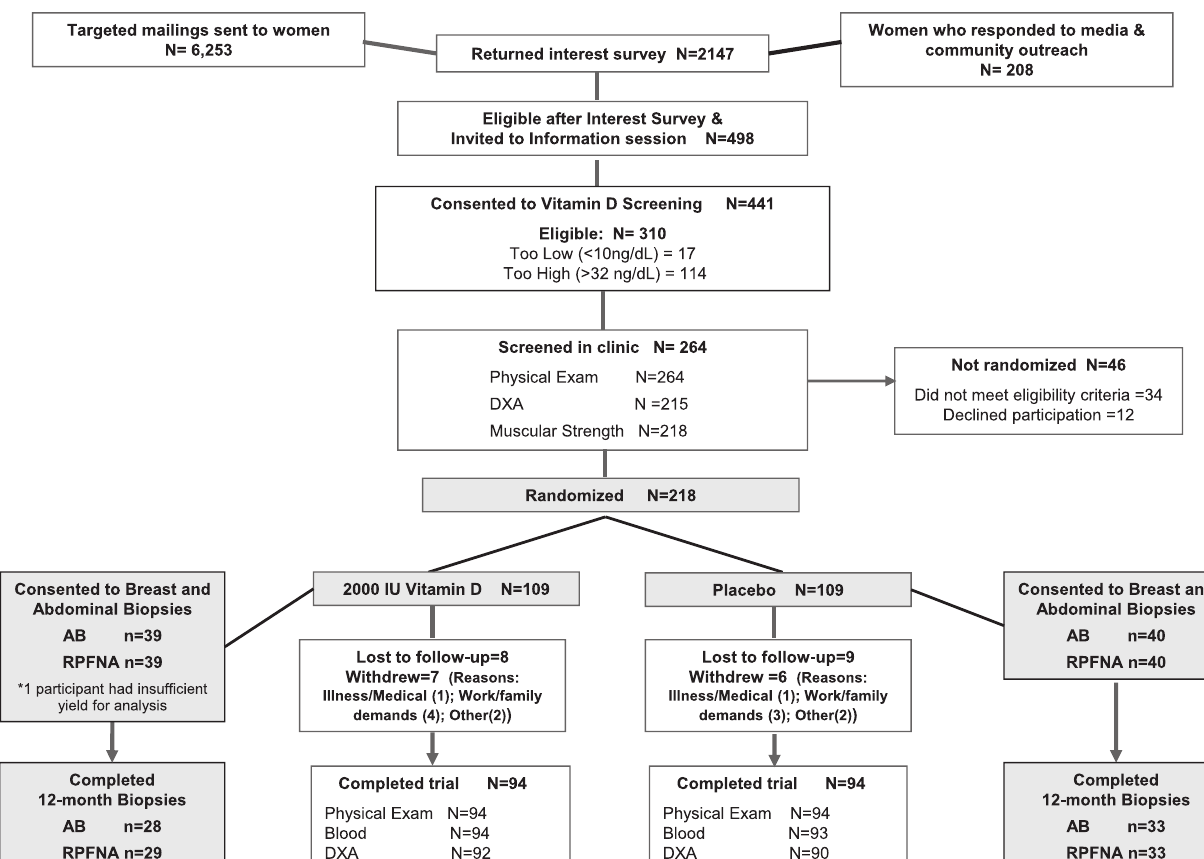
Fig. 2 Flow of participants through the Vitamin D, Diet, and Activity (ViDA) study and tissue marker